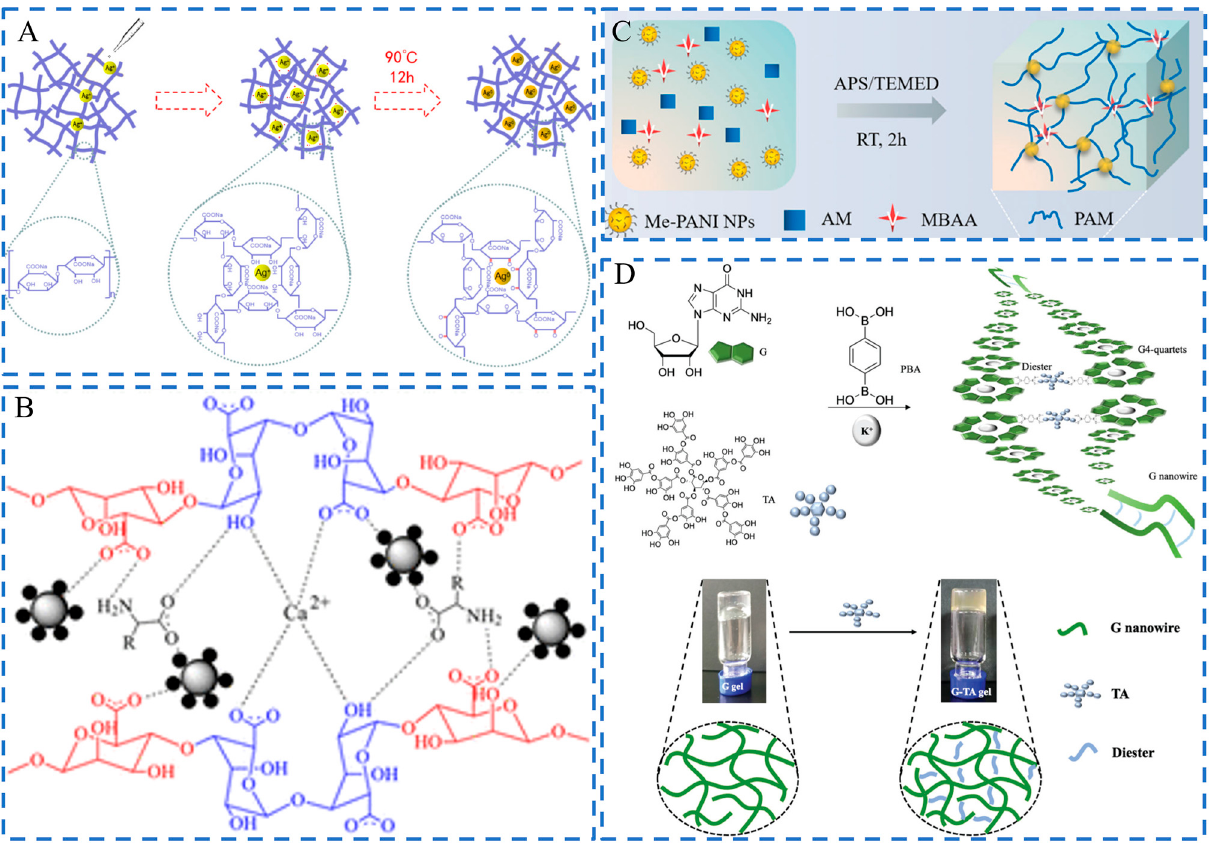
Figure 2. Schematics of fabrications of NMFHs by physical embedding and chemical synthesis. ( A ) Formation of an NMFH through embedding Ag NPs in the PVA/SA/CMCS-based network. Adapted with permission [42]. Copyright 2020, Elsevier. ( B ) The network structure of the NMFH is based on SA, Ag@TiO 2 NPs, amino acids, and Ca 2+ . Adapted with permission [44]. Copyright 2020, The American Chemical Society. ( C ) Schematic of the formation of the NMFH from Me-PANI NPs, AM, and N , N’ -methylenebisacrylamide (MBAA) through free radical copolymerization. Adapted with permission [45]. Copyright 2021, Wiley-VCH. ( D ) Schematic of the formation of the NMFH based on G NWs, K + , TA, and PBA. Adapted with permission [46]. Copyright 2022, The Royal Soci- ety of Chemistry.